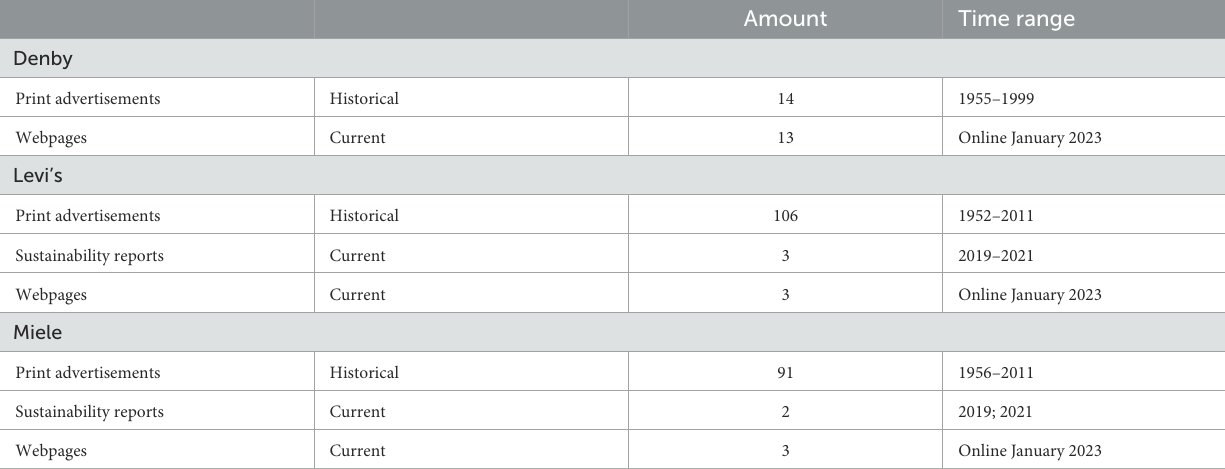
TABLE 2 Overview of data types collected per business